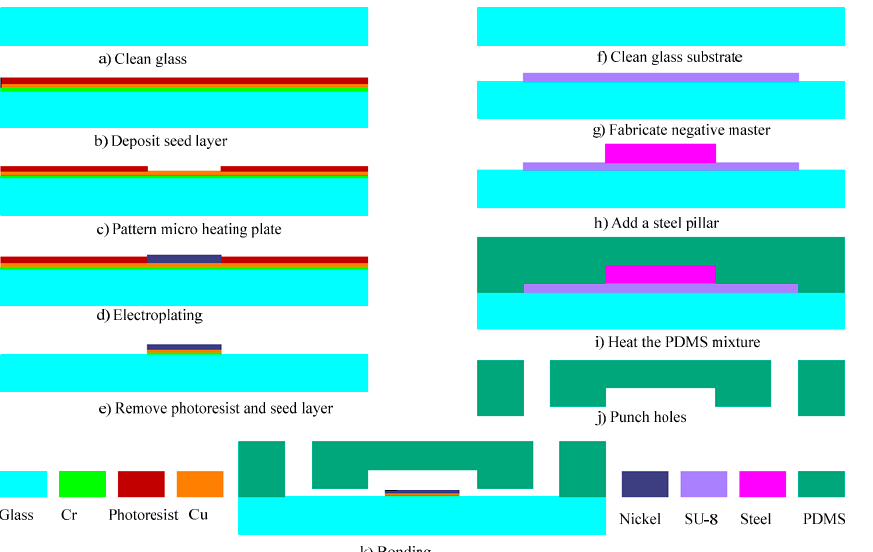
Figure 5. Fabrication process of the thermal bubble-driven micropump. ( a ) Clean Class; ( b ) Deposit seed layer; ( c ) Pattern micro heating plate; ( d ) Electroplating; ( e ) Remove photoresist and seed layer; ( f ) Clean glass substrate; ( g ) Fabrication negative master; ( h ) Add a steel pillar; ( i ) Heat the PDMS mixture; ( j ) Punch holes; ( k ) Bonding.